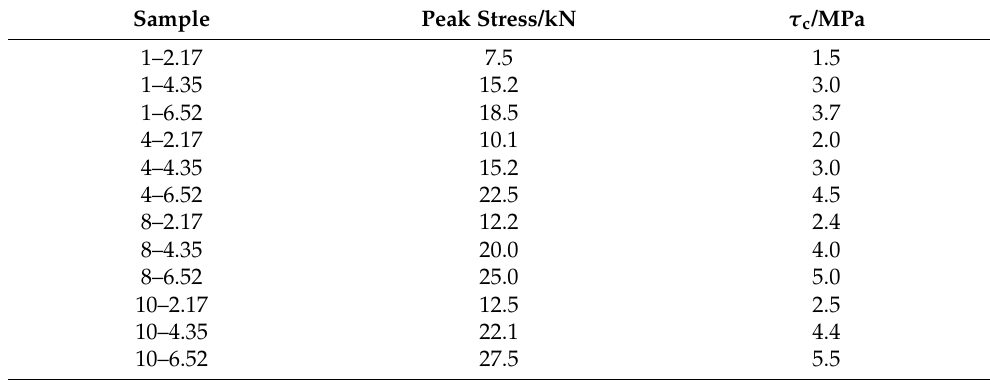
Table 2. Shear strength of each sample ( τ c is shear